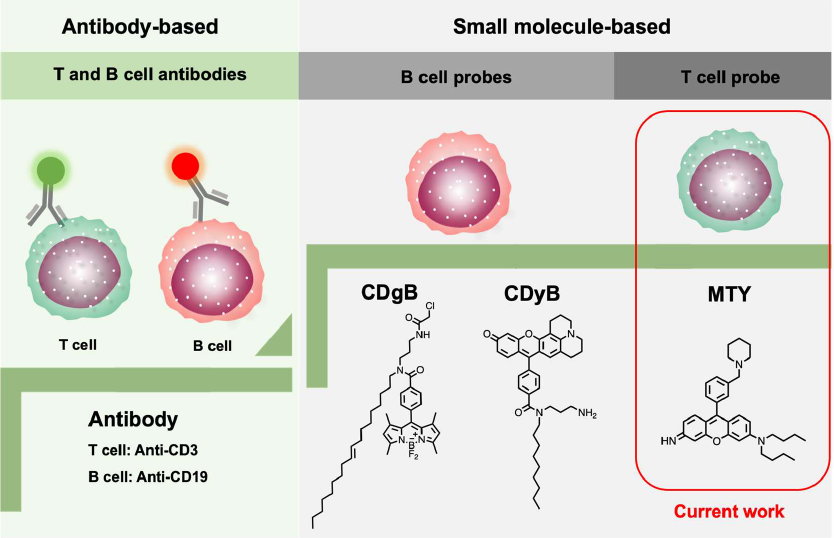
Figure 1. Development progress of T- and B-cell identification.